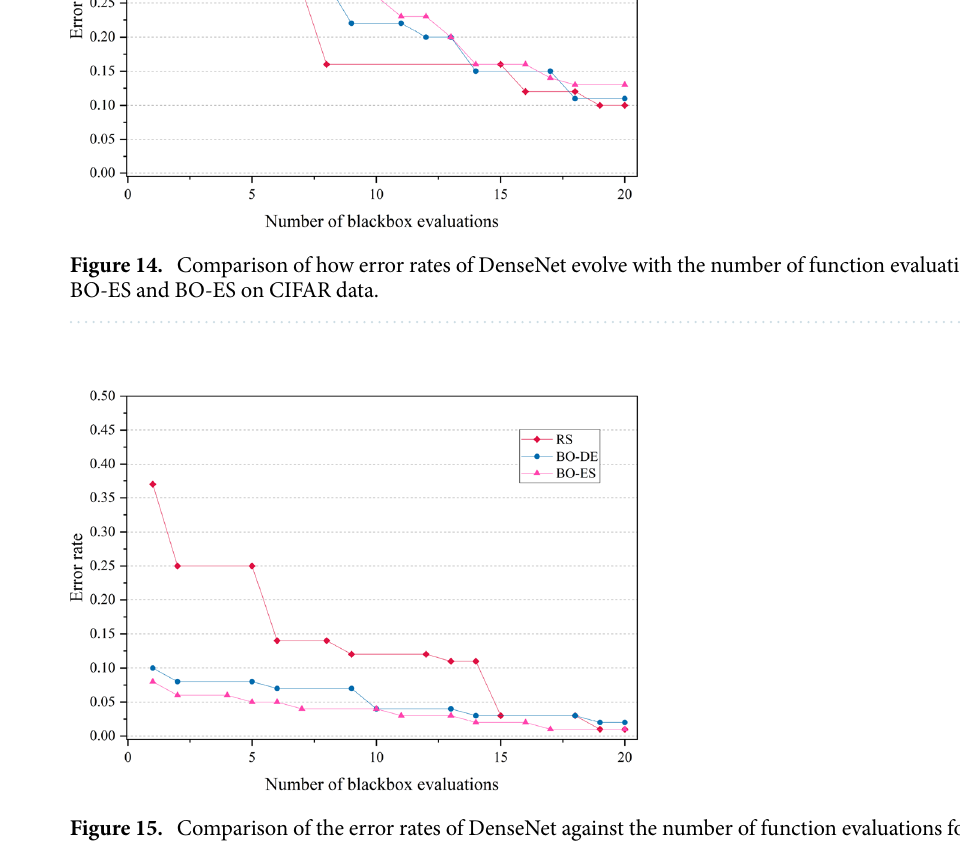
Figure 15. Comparison of the error rates of DenseNet against the number of function evaluations for BO-ES, BO-ES, and RS using MNIST data.